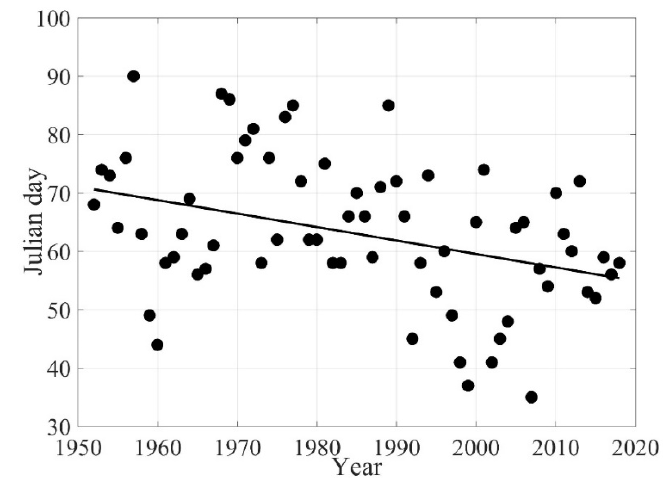
Figure 6. HIGHTSI modeled sea ice breakup date (black circles) for each winter season and fitting trend line generated by the Theil–Sen estimator.